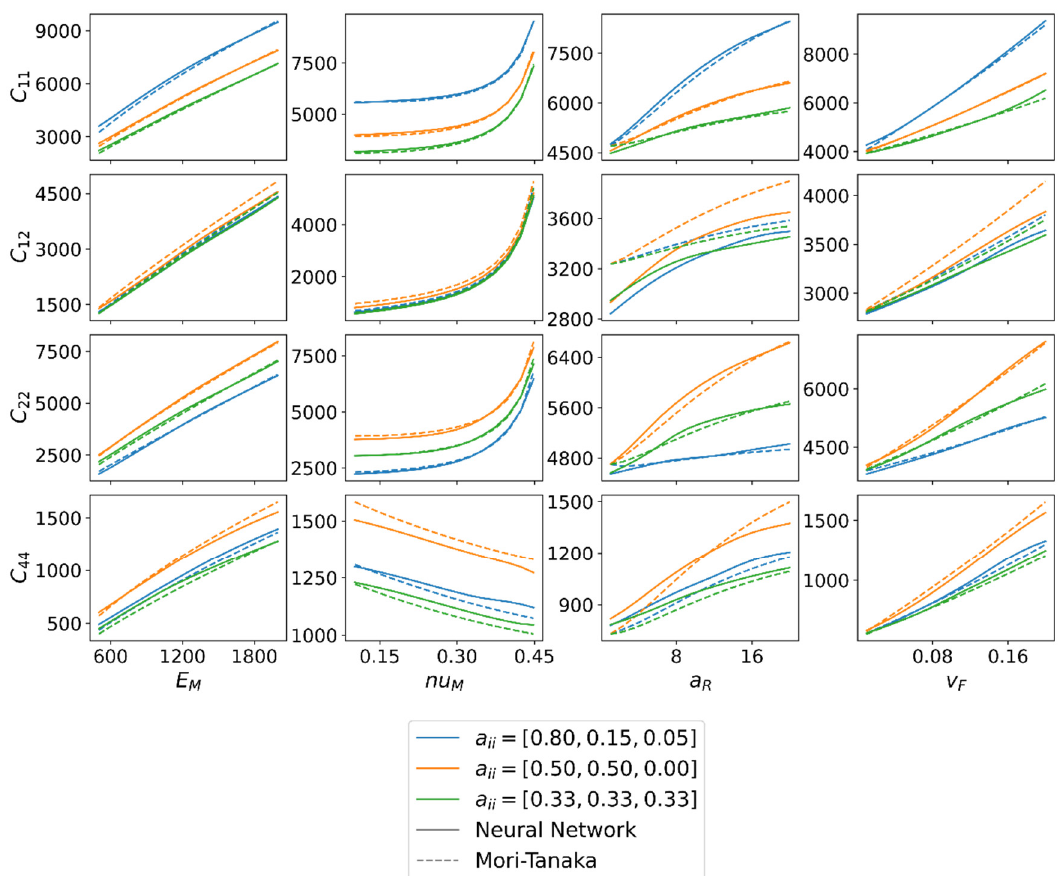
Figure 9. Direct comparison between model predictions of NN and MT for different input parameters. All input parameters are constant (see Table 2) except that one which is varied in the associated column.